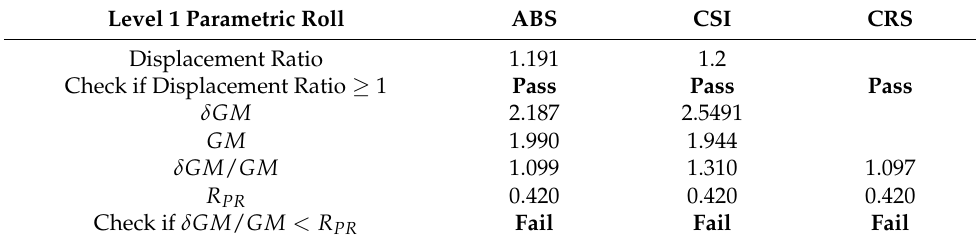
Table 21. Level 1 assessment of parametric roll failure mode for C11 container ship.